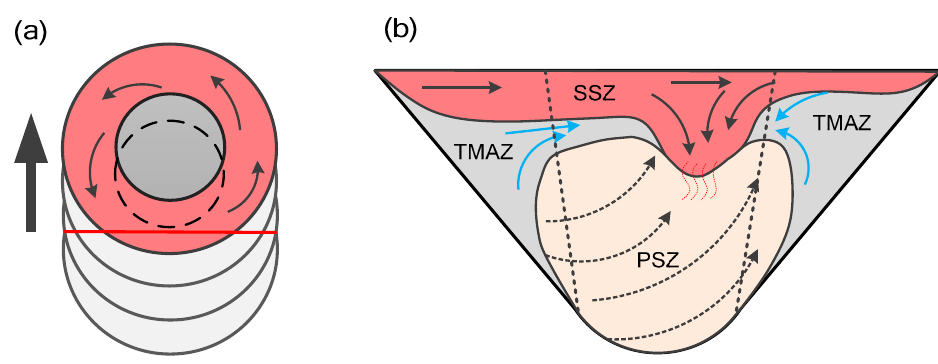
Figure 18. Schematic diagram of turbulent defect formation. ( a ) The surface of the welded joint; ( b ) the cross section of the welded joint.